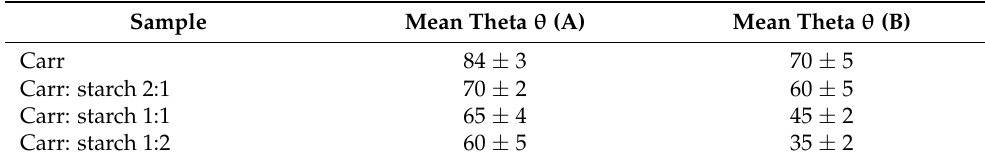
Table 3. Water contact angle values of Carr/starch membranes before (A) and after (B) enzymatic